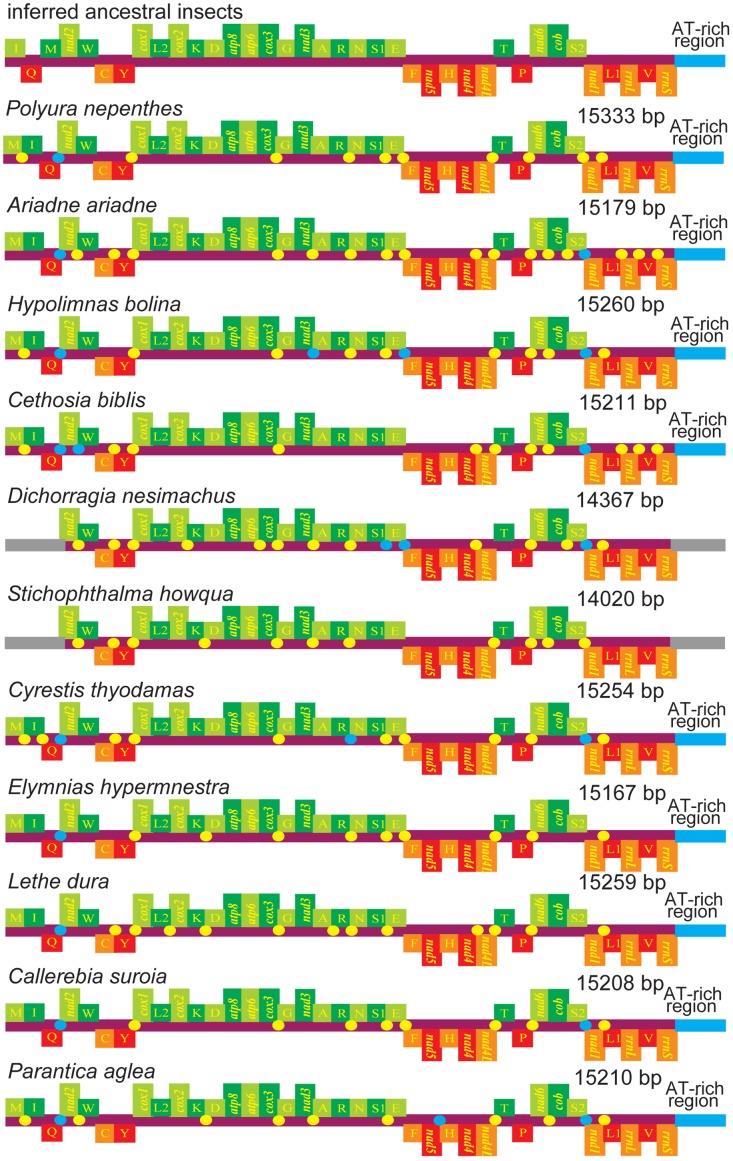
Gene arrangement of eleven nymphalid mitochondrial genomes sequenced in this study.Abbreviations for the genes are as follows: cox1, cox2, and cox3 refer to the cytochrome oxidase subunits, cob refers to cytochrome b, and nad1—nad6 refer to NADH dehydrogenase components, rrnL and rrnS refer to ribosomal RNAs. Transfer RNA genes are denoted by one letter symbols according to the IPUC-IUB one-letter amino acid codes. L1, L2, S1, S2 denote tRNALeu(CUN), tRNALeu(UUR), tRNASer(AGN), tRNASer(UCN), respectively. Genes coded on the majority strand are light/dark-green. Genes coded on the minority strand are red or orange. Alternation of colors was applied for distinction. The non-coding regions are presented as cyan/yellow dots. The unknown portions of partial mtDNAs are gray.